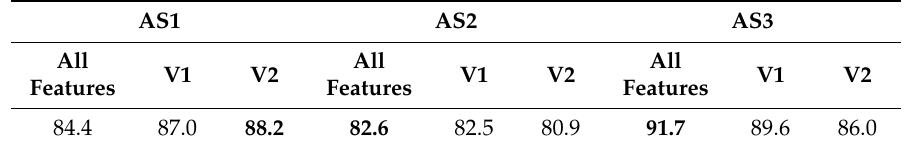
Classification times using representatives were compared in Table 13.